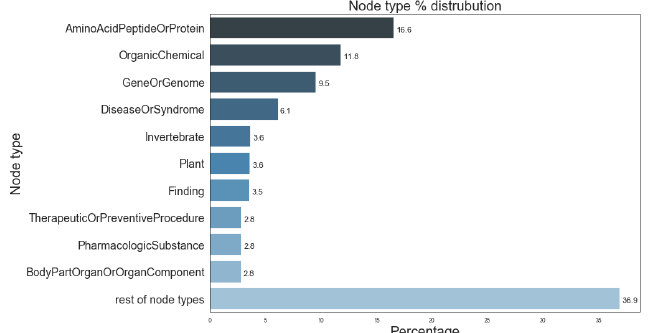
Figure 5. Distribution of most prevalent node types in SemNet ([16]). “Rest of node types” represents the aggregate of remaining node types not individually listed in the figure due to space